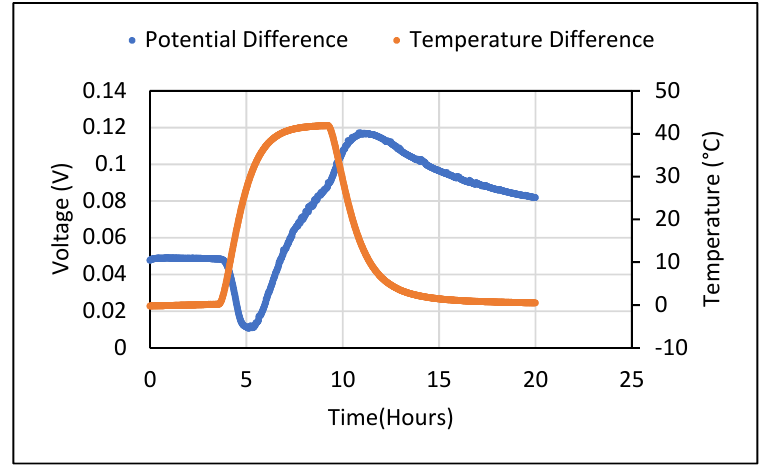
Figure 6. Potential difference obtained from a 5 wt.% Fe 2 O 3 sample in saturated condition with changing temperature gradient.